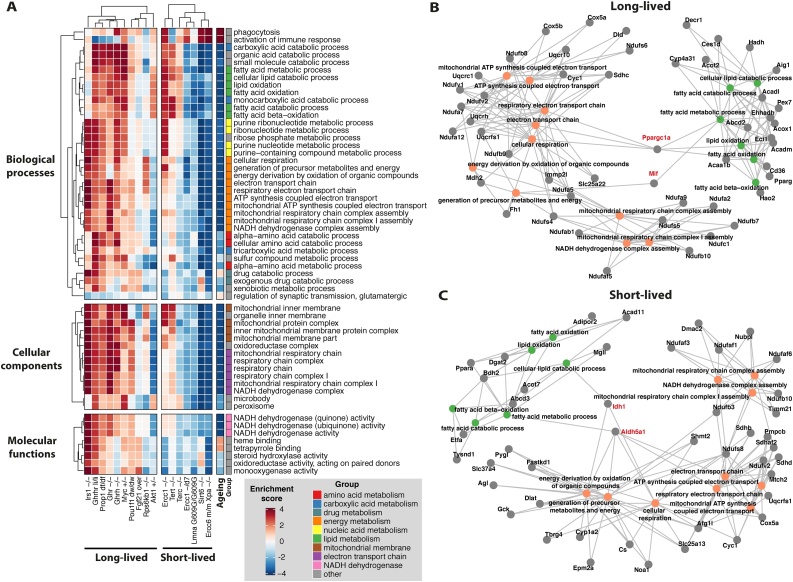
(A) Gene sets showing consistent changes in long- and short-lived mice (FDR < 0.05). The heatmap colours represent the statistical significance of the enrichment and the direction of the change. The ‘Ageing’ column represents the enrichment scores associated with the transcriptomic changes during ageing. The ‘Group’ column indicates different groups of gene sets with similar function. Genes involved in the regulation of biological processes linked with energy and lipid metabolism in (B) long-lived and (C) short-lived mice. Labelled in red are genes involved in both sets of processes. Nodes representing genes are coloured in grey, and nodes from biological processes are coloured based on the groups in panel A.